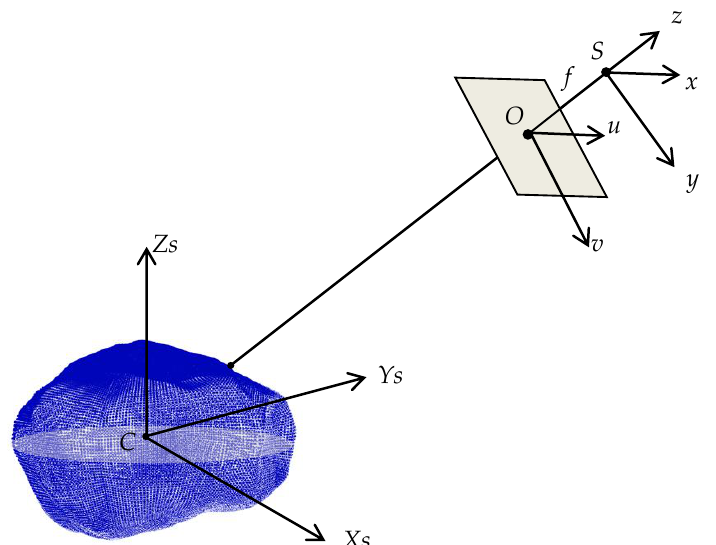
Figure 1. Schematic diagram of the Phobos imaging model. The S-xyz is the image space coordinate system that uses the projective center ( S ) as its origin. The O-uv is the photo coordinate system and the origin of it is the principal point ( O ) of the image. The C-XsYsZs is the Phobos-fixed coordinate system defined by IAU. The f is the focal length of the camera. The gray plane is the image plane. The blue ellipsoid is the shape model of Phobos.